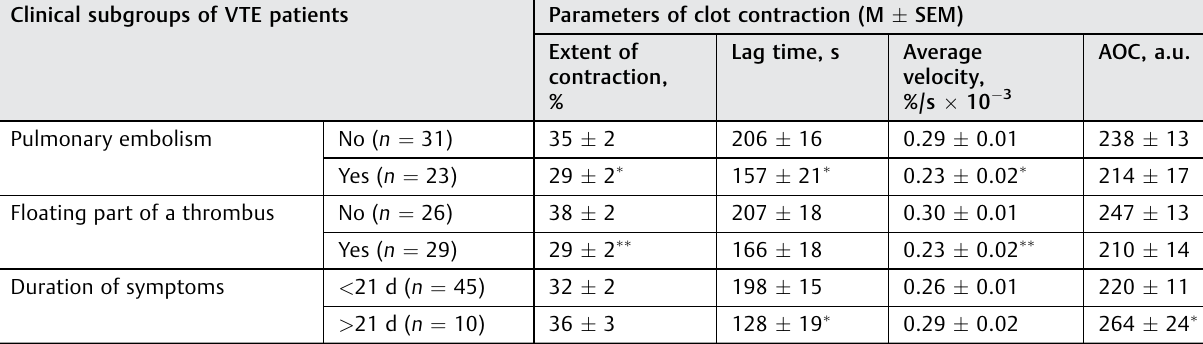
Table 4 Blood clot contraction in the clinical subgroups of patients with VTE Clinical subgroups of VTE